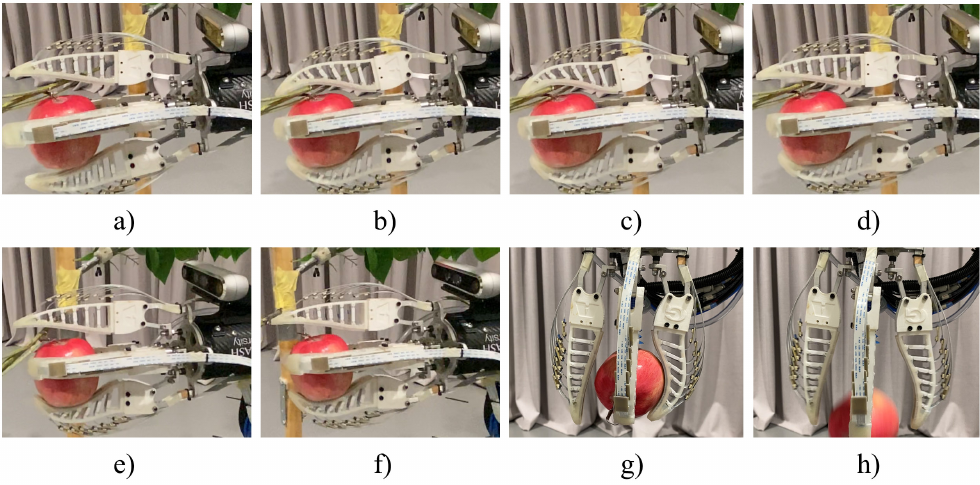
Figure 13. Motion Sequence: ( a ) gripper reach target; ( b ) grasp action; ( c ) tactile perception; ( d ) in- terference detected; ( e ) finger released; ( f ) gripper retraction; ( g ) gripper reach dropping point; ( h ) fruit